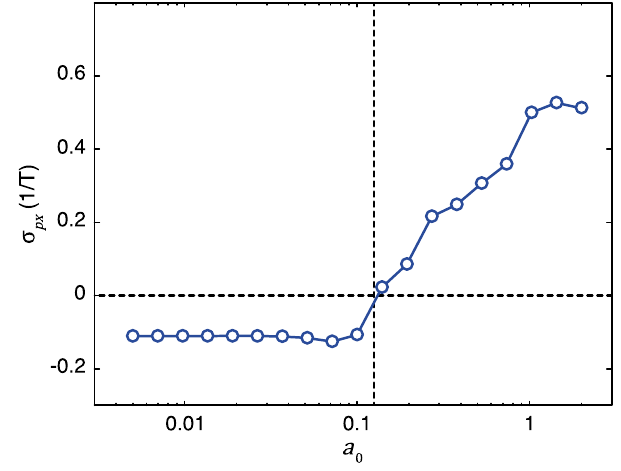
FIG. 9. Lyapunov exponent for the p x variable in the long- gradient regime, as a function of a 0 . Simulations have been performed in the physical configuration of case A of Fig. 8. The onset of stochastic heating in the standing wave formed in the underdense part of the plasma by the incident and reflected laser fields is indicated by the fact that the Lyapunov exponent becomes positive. The calculation procedure used to deduce this exponent from the results of 2D plane wave PIC simulations is explained in the Supplemental Material